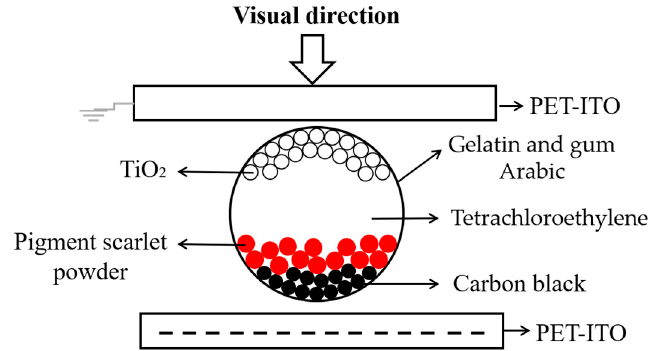
Figure 1. A pixel structure of a three-color EPD. The common electrode is connected to ground, and a negative voltage is applied to the pixel electrode. At this time, white particles are driven to the top of the microcapsule.